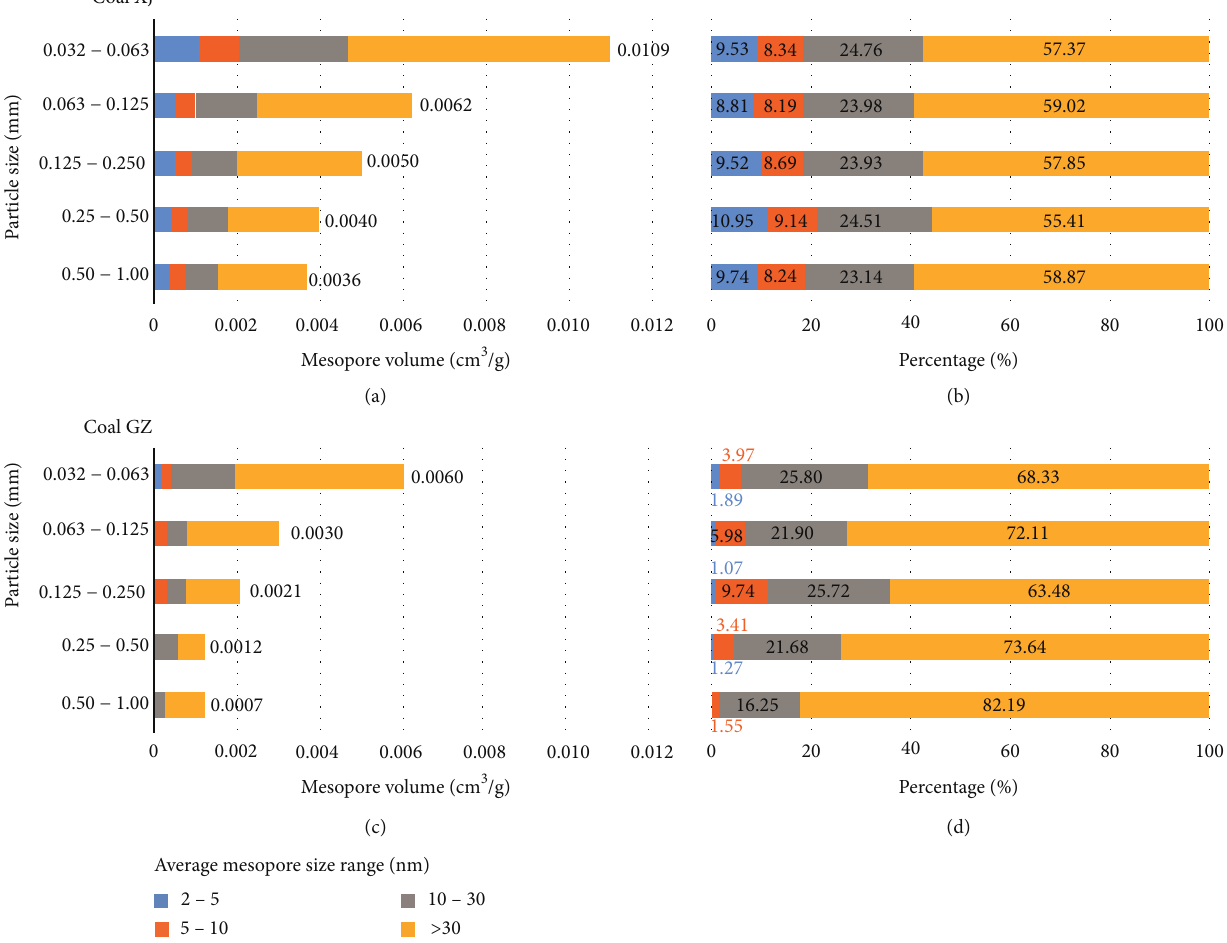
Figure 9: Horizontal and stacked bar charts of mesopore volume and proportion corresponding to speci fi c pore size ranges for Coal XJ (a, b) and Coal GZ (c, d). Mesopore size ranges 2 – 5, 5 – 10, 10 – 30, and > 30